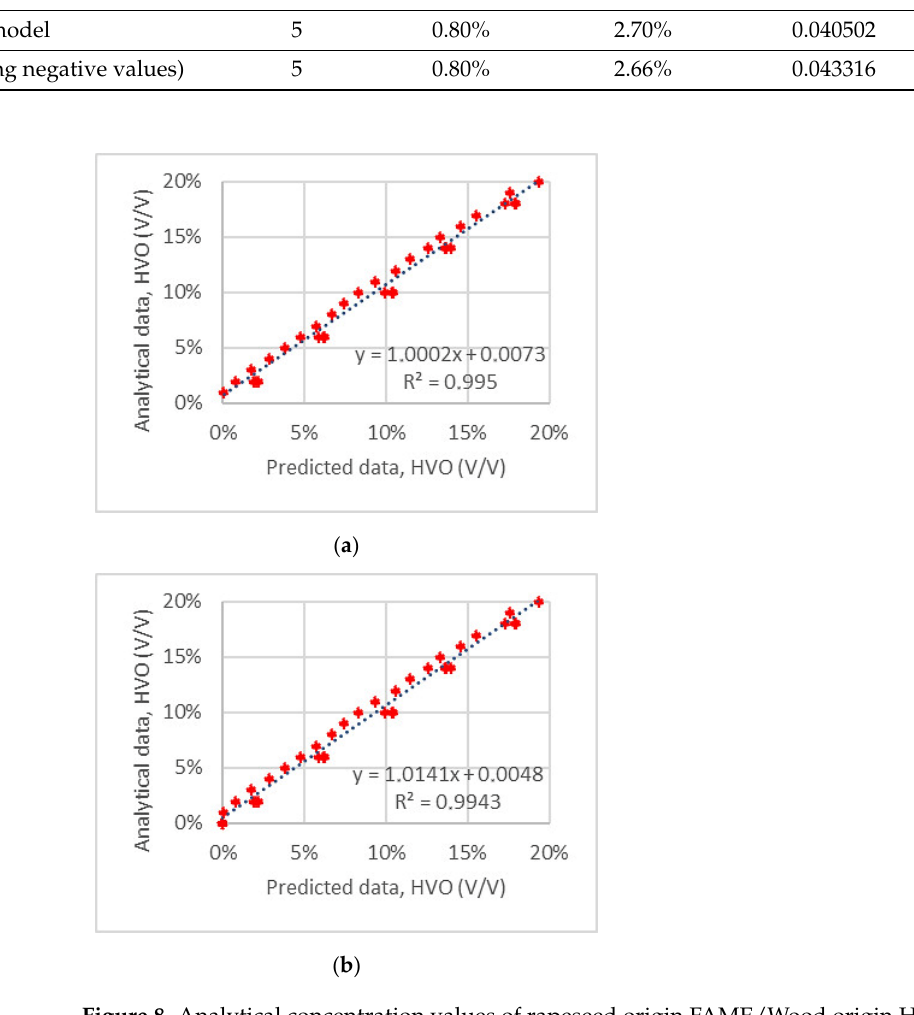
Figure 8. Analytical concentration values of rapeseed origin FAME/Wood origin HVO (Bioverno) diesel blend validation samples versus predicted values using HVO quantification PLS model: ( a )—PLS model predictions, ( b )—PLS model prediction with data interpretation.